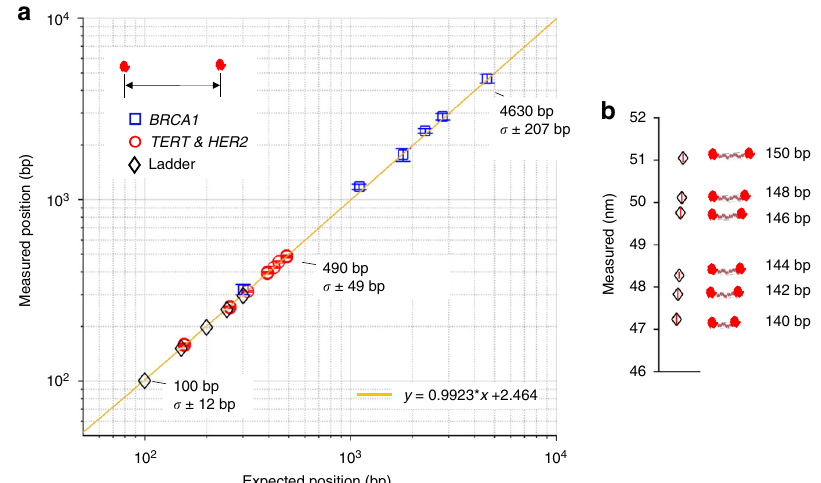
Fig. 3 HS-AFM accurately localizes sgRNA – Cas9 complexes on DNA. a Measured vs. expected position of the Cas9 labels determined for BRCA1 , TERT- HER2 , and ladder constructs. Error bars represent the 95% con fi dence interval of the mean. For the TERT-HER2 and ladder data points, the symbol diameter is larger than the 95% con fi dence interval span. The expected size and sample standard deviation ( σ ) are indicated at three points for reference. b Sizing closely spaced ladder constructs, end-labeled with Cas9. Vertical red lines inside symbols represent the 95% con fi dence interval of the mean. See Methods for measurement